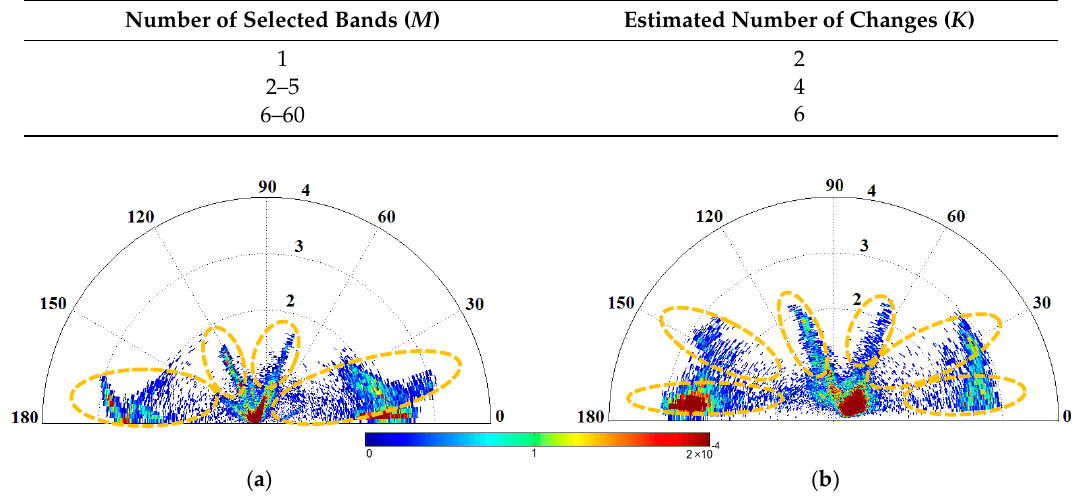
Table 6. Estimated number of changes in multiple CD with different number of selected bands (Umatilla county dataset).